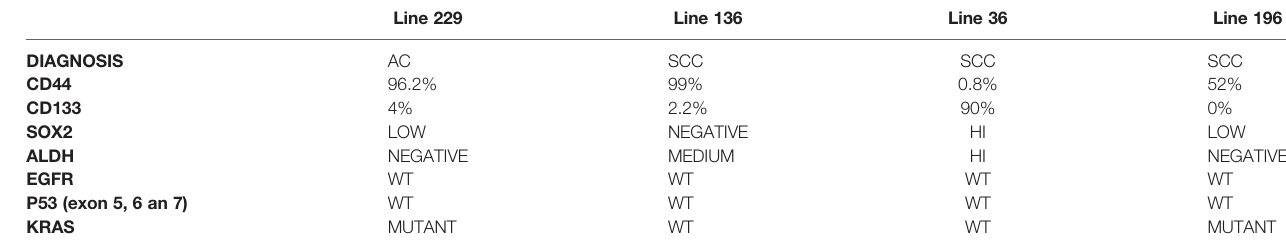
TABLE 2 | Histological, molecular, and functional properties of lung cancer CSCs lines.